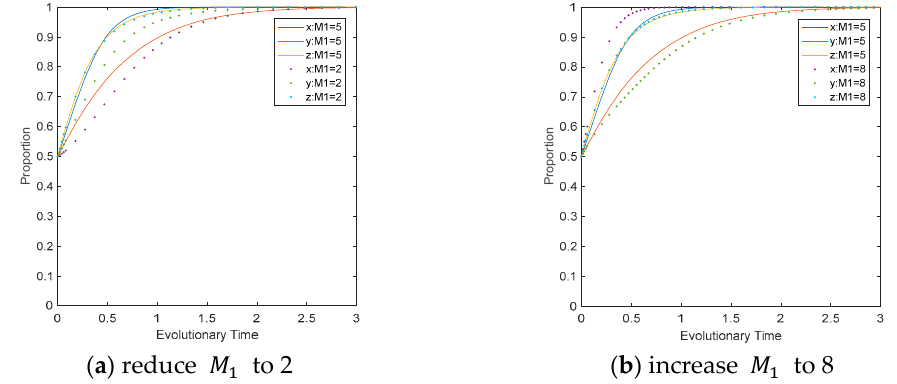
Figure 8. Impact of M 1 on the evolutionary path of multi-agents.